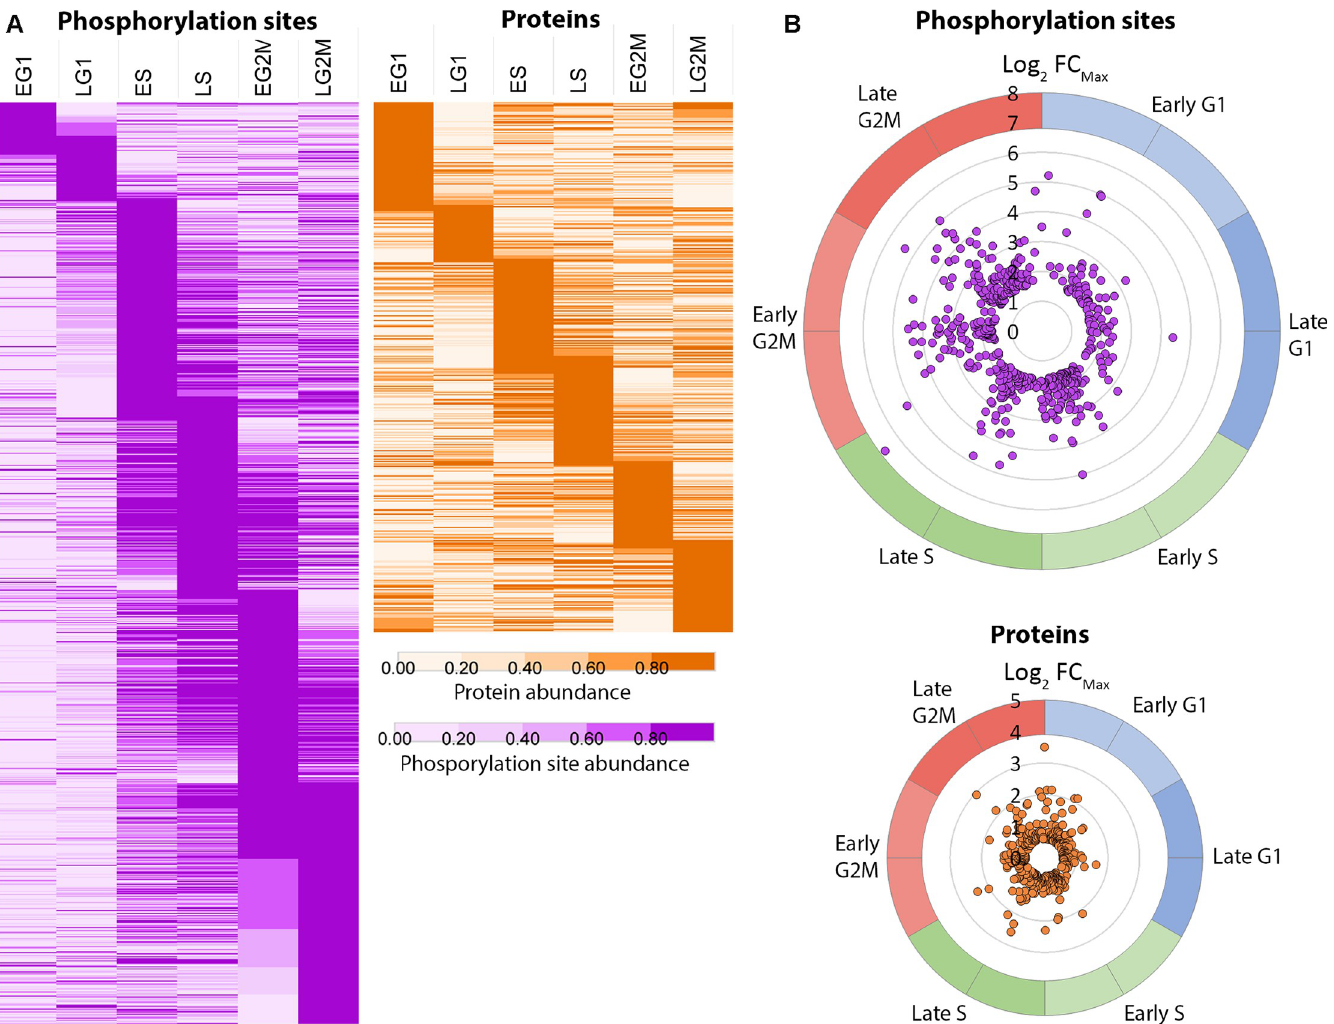
Fig 2. Cell cycle regulated phosphorylation sites and proteins. A. Species ordered in increasing peak time (t peak ) and rendered as a heat map of fold change scaled to the unit integer. B. CCR species projected on a polar plot of peak time t peak (angle of polar coordinate) versus the maximum fold change FC Max .(distance from the centre). Five phosphorylation sites showing > 100-fold change were excluded for